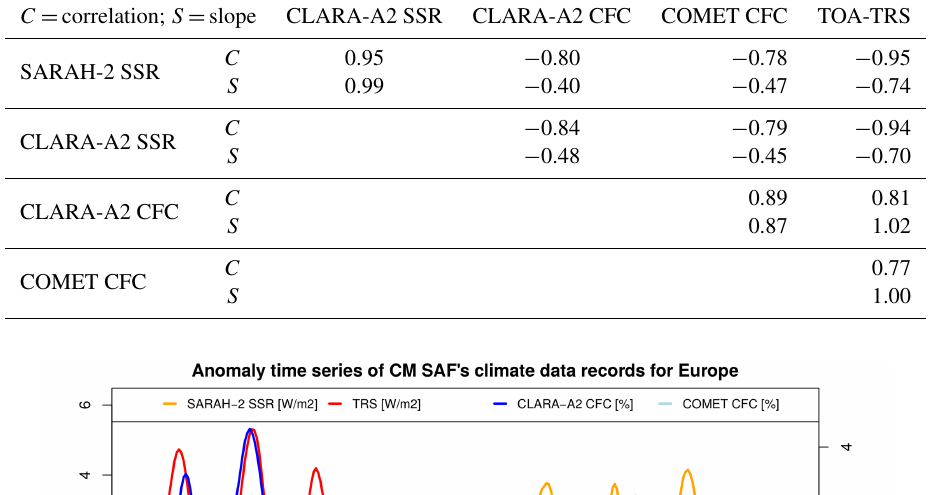
Table 1. Results of the linear regression ( C = Pearson’s correlation coefficient, S = slope of regression line) between the monthly anomalies (grid-point wise) of the five data records for the common European domain (shown in Fig. 2). The values refer to the period 1992–2015. C = correlation; S = slope